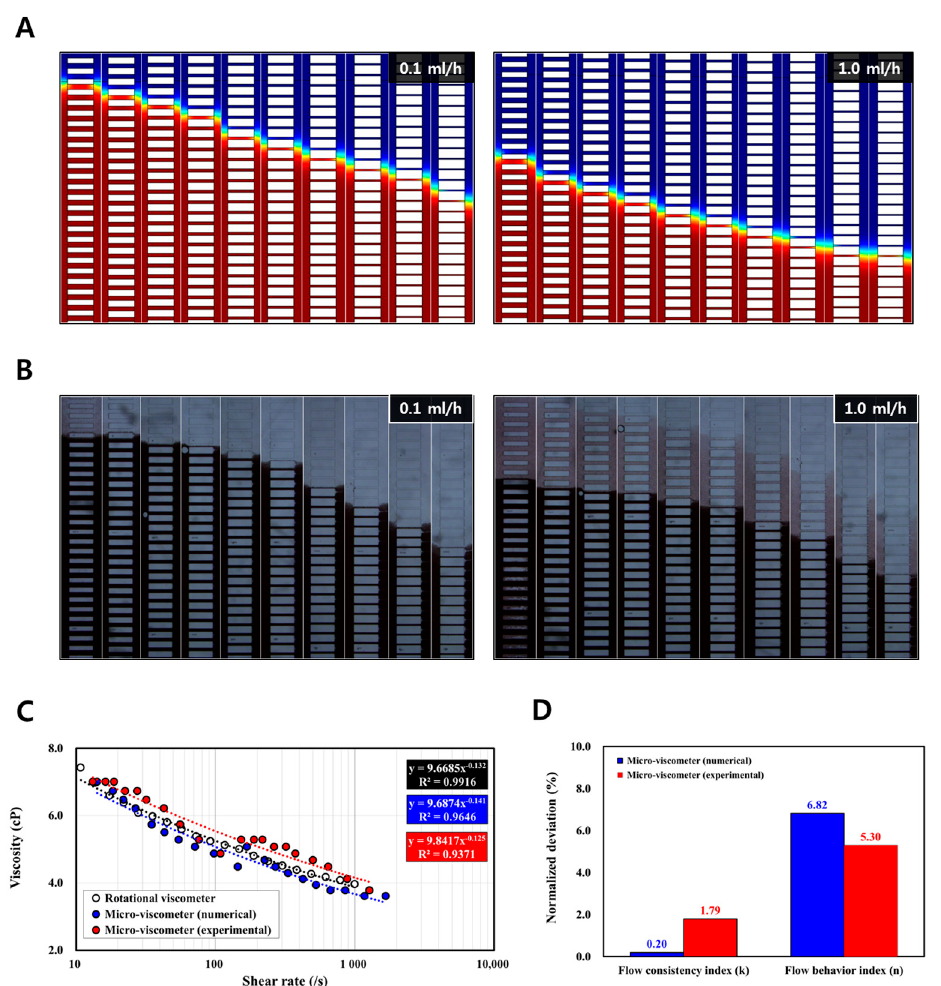
Figure 4. Numerical and experimental demonstrations of the micro-viscometer. ( A ) For the given flow rate conditions (0.1 and 1.0 mL/h), the captured images of 10 counting sections showing the fluidic boundaries are depicted. The number of channels filled with the sample fluid (red) range from a maximum of 50 to a minimum of 39 in the low shear rate regime (14.2–145.4/s), and to a minimum of 34 in the high shear rate regime (168.8–1668.3/s). ( B ) Captured images showing fluidic boundaries in the 10 counting sections. The number of channels filled with the blood sample decreased from a maximum of 50 to a minimum of 41 (for the flow rate of 0.1 mL/h), and decreased from a maximum of 43 to a minimum of 35 (for the flow rate of 1.0 mL/h). ( C ) The viscosity values from the numerical study (blue circle) are obtained from two flow rate conditions, which can be fitted with 9.69 (for k) and − 0.14 (for n) using the power-law model. Also, 20 viscosity values (red circle) obtained from the experiment are fitted using the power-law model with 9.84 (for k) and − 0.13 (for n). ( D ) It is confirmed that the numerical result shows relative errors of 0.2% (for k) and 6.8% (for n) and the experimental result shows relative errors of 1.79% (for k) and 5.30% (for n). This implies that the micro-viscometer design concept enables accurate measurement of the shear-thinning viscosity.